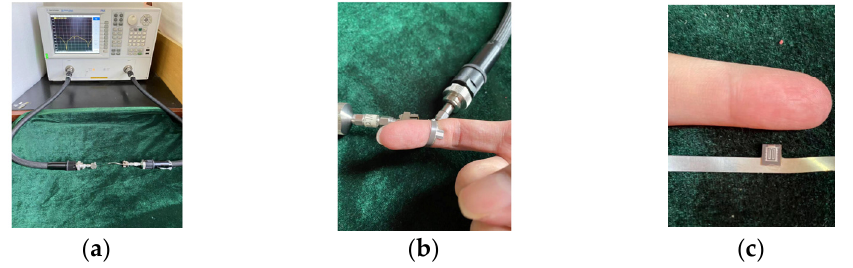
Figure 11. ( a ) Measurement operation of sensor; ( b ) Wrap the finger; ( c ) Sensing unit of the sensor. The curvature of the sensor has little effect on its resonant frequency and magnitude of reflection coefficient. As shown in Figure 12, the resonant frequency of the sensor bent to 0 ◦ , 52 ◦ , 70 ◦ and 112 ◦ , is almost 11.6 GHz. The magnitude of the reflection coefficient of the sensor bent to the above four curvatures is almost − 45 dB. The sensor can be bent to any curvature to measure the skin because of its insensitivity to curvature.